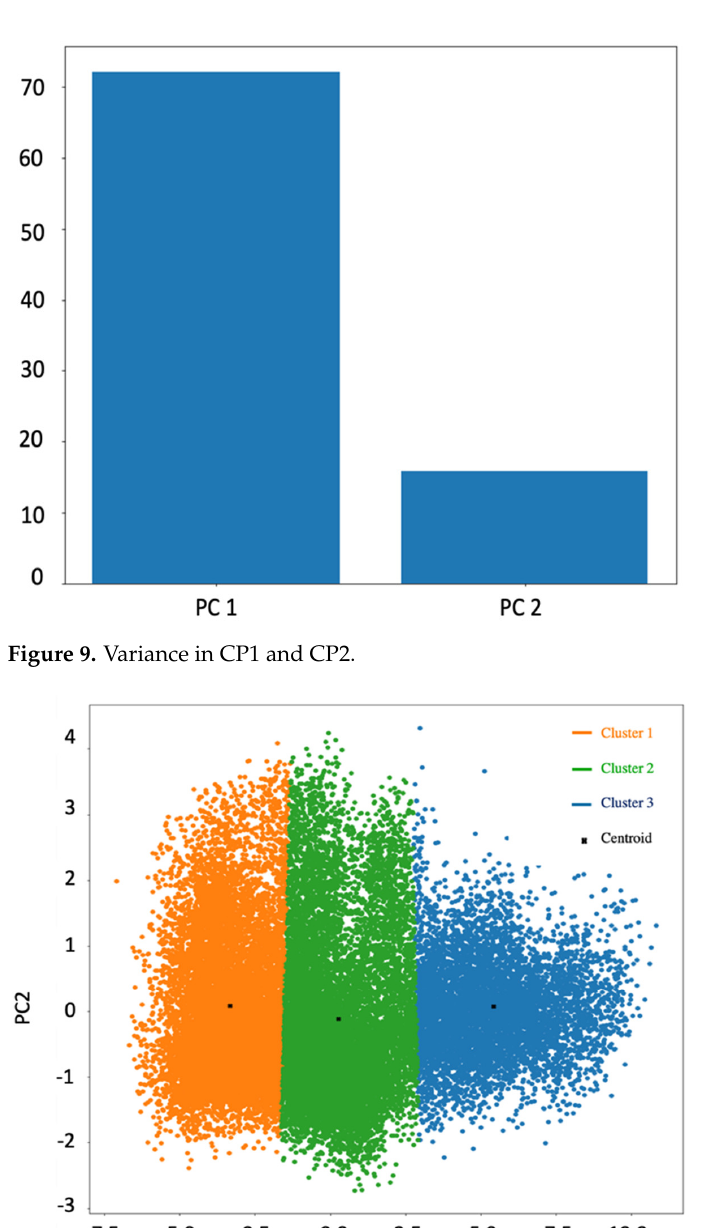
Figure 10 . Representation of the data in the three clusters according to CP1 ( x -axis) and CP2 ( y -axis).